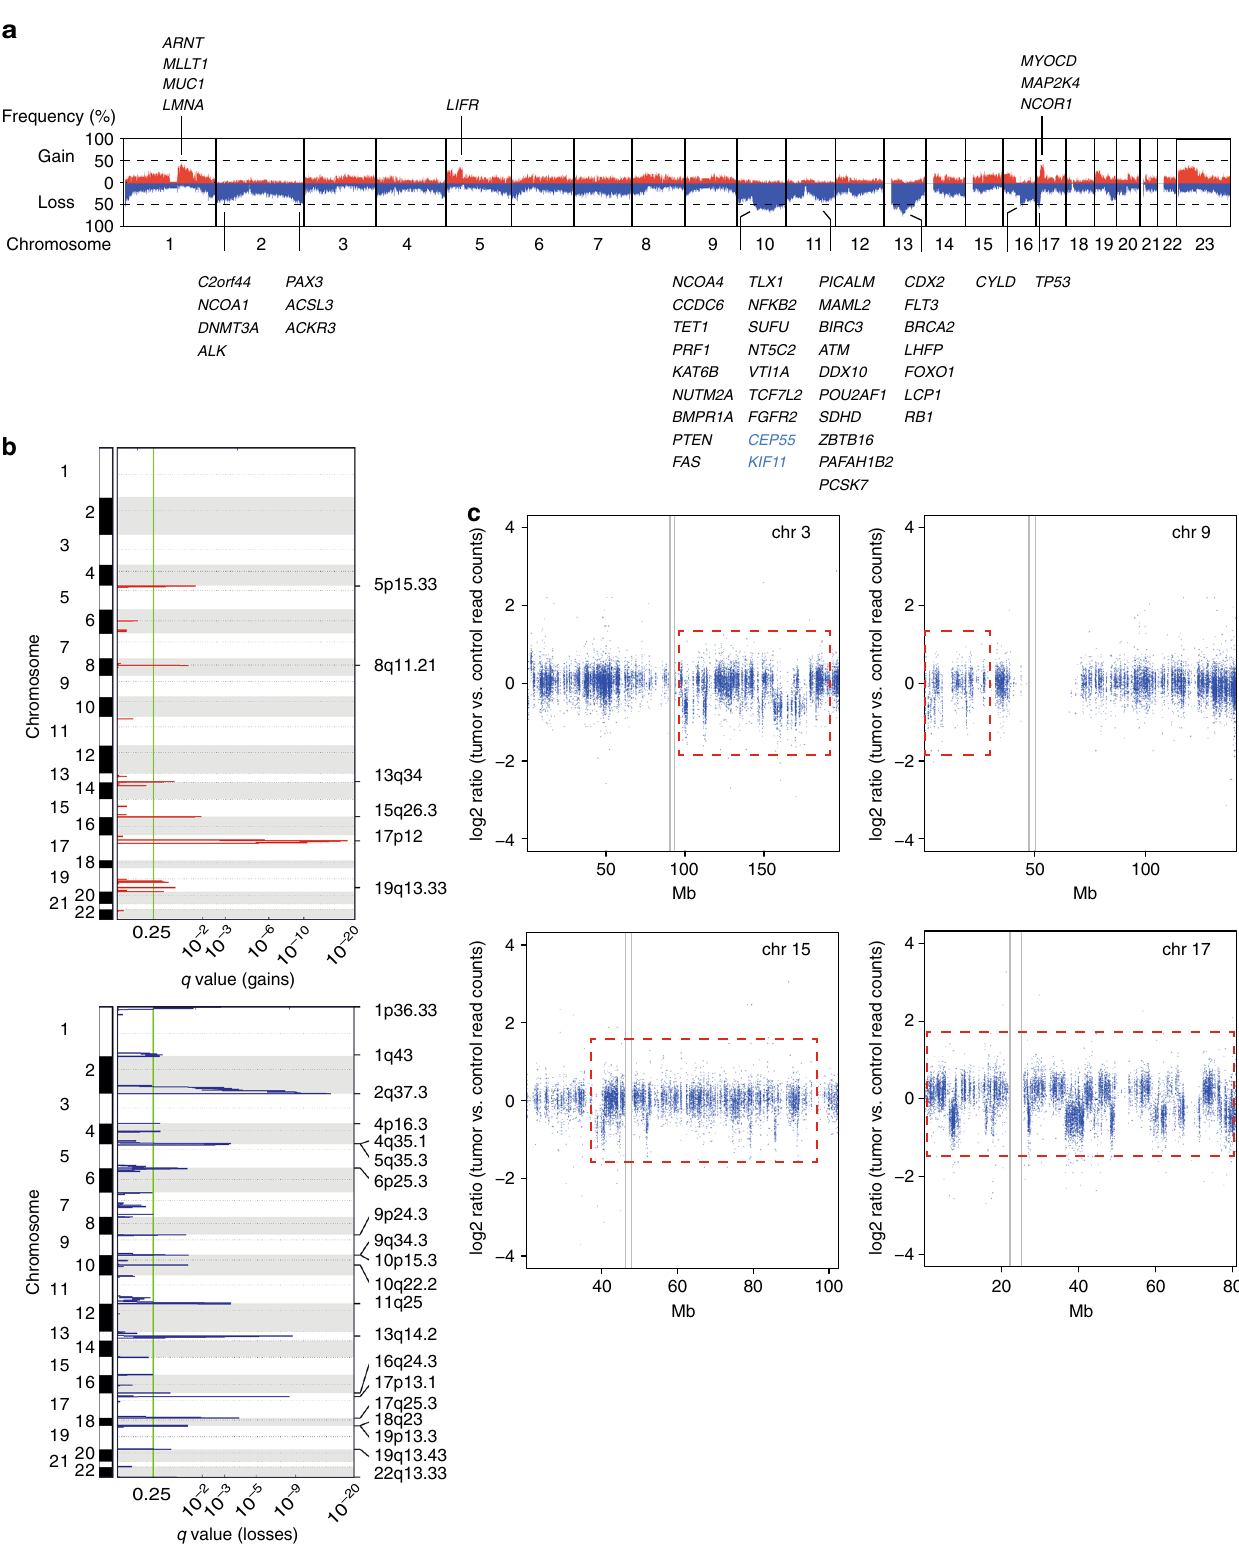
Fig. 2 Genomic imbalances in adult LMS. a Overall pattern of CNAs. Chromosomes are represented along the horizontal axis, frequencies of chromosomal gains (red) and losses (blue) are represented along the vertical axis. Established cancer genes (black) and components of the CINSARC signature (blue) affected by CNAs in at least 30% of cases are indicated. b GISTIC2.0 plot of recurrent focal gains (top) and losses (bottom). The green line indicates the cut-off for signi fi cance ( q = 0.25). c Read-depth plots of case LMS24 showing oscillating CNAs of chromosomes 3, 9, 15, and 17 (red dotted lines), indicative of chromothripsis. Gray lines indicate centromeres. Mb megabase, chr